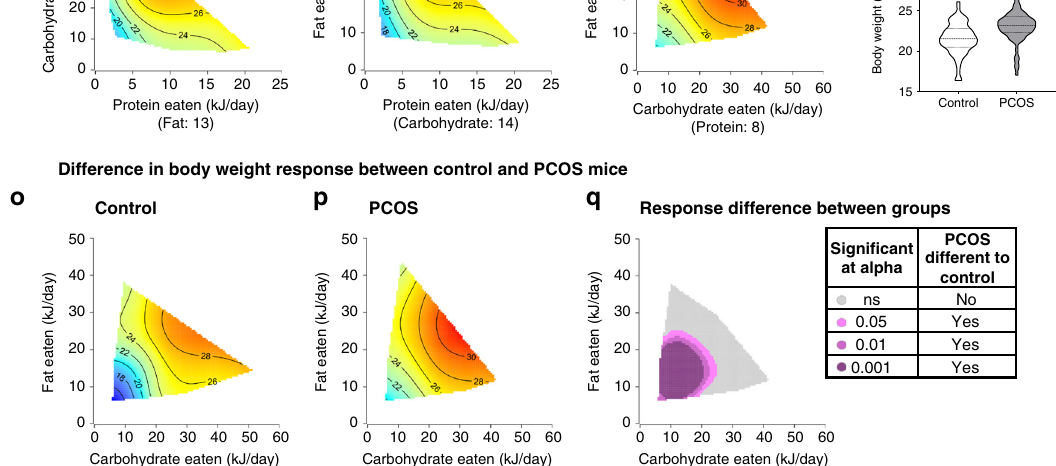
agreement with previous mouse PCOS studies 26,28 . Analysis of changes in response to diet for adipocyte size, revealed the same pattern as changes in response to diet for body weight between control and PCOS mice. PCOS mice were more sensitive to low macronutrient intakes, but otherwise both groups displayed comparable patterns of response to macronutrient intake (Fig. 4c). Adiponectin is an adipokine that is reduced in serum of PCOS patients 29 – 31 and PCOS animal models 26,30 . In this study, adiponectin levels were signi fi cantly decreased in PCOS females compared to control females (11221 ± 453.8 ng/ml vs. 16806 ±